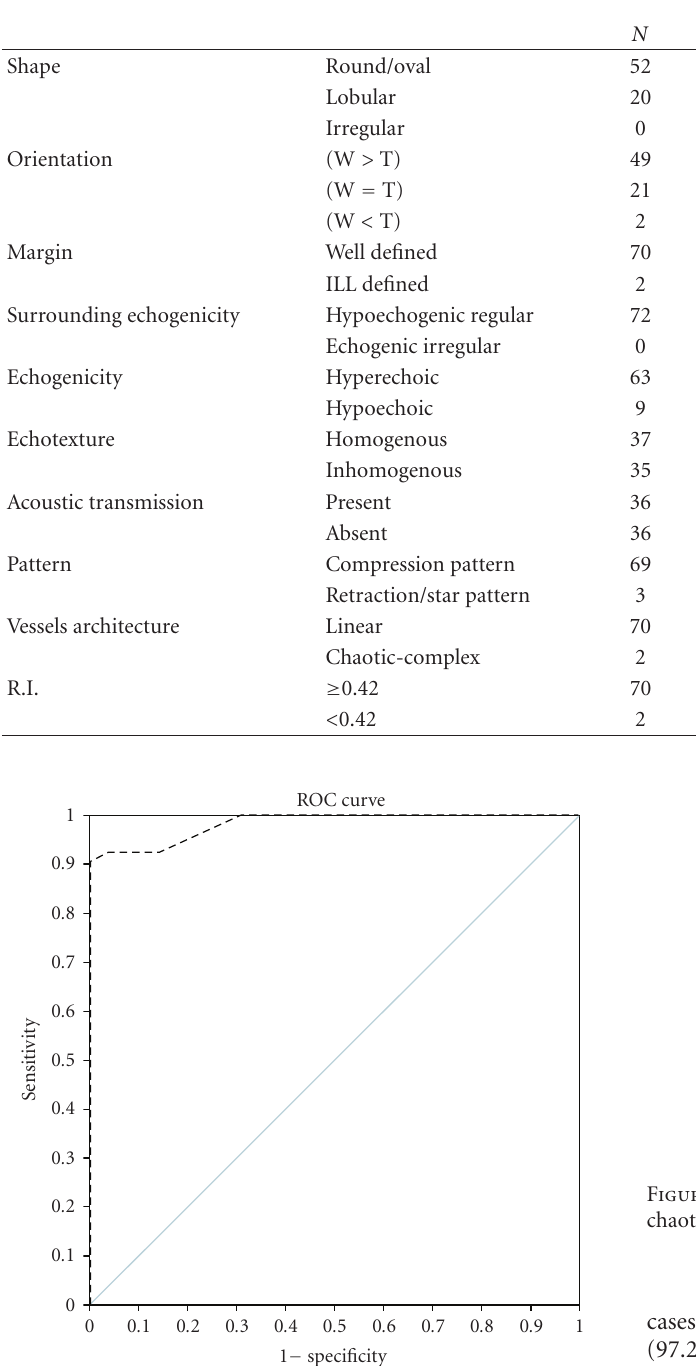
Figure 3: High diagnostic capability of 3D ultrasound in di ff eren- tiating benign from malignant breast tumors. between malignant and benign tumors were found statis- tically significantly in all of the ten criteria used: benign tumors appeared in a round/oval shape in 52 cases (72.2%), with the horizontal diameter wider than the vertical in 49